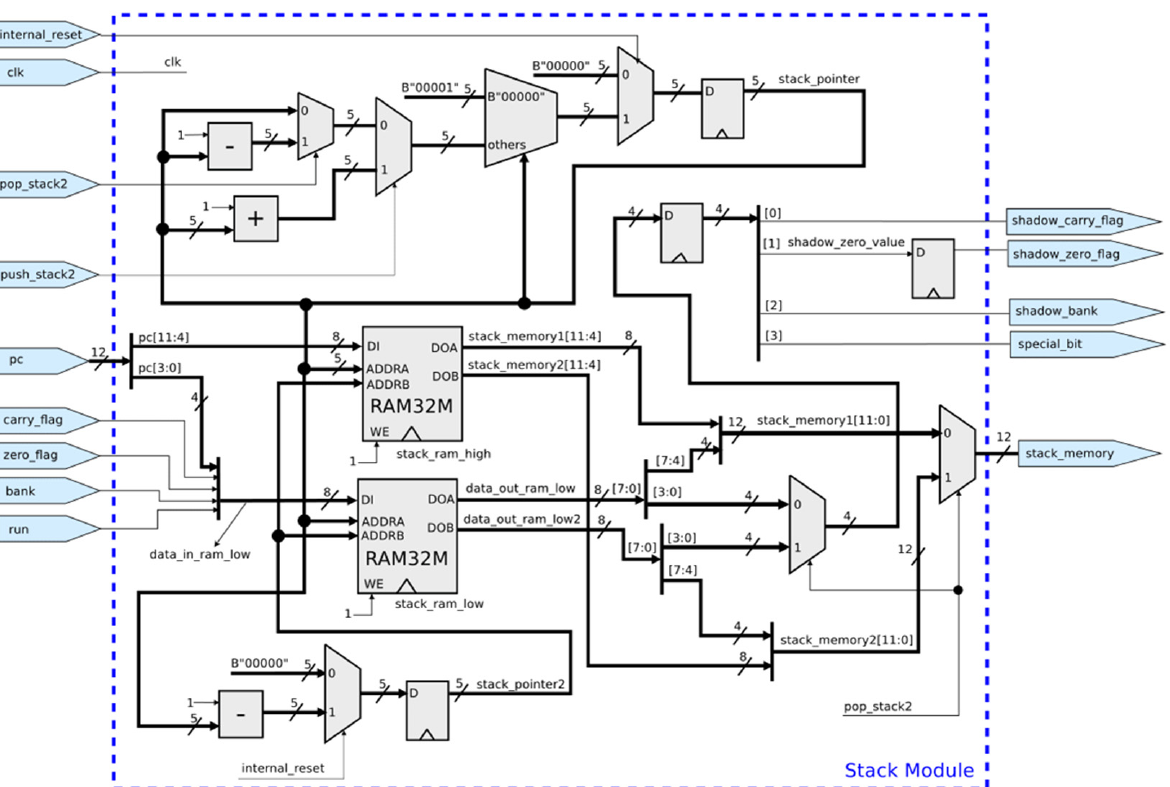
Figure 12. Stack module with prediction circuit added (a high-resolution version of this figure is available in Supplementary S3).